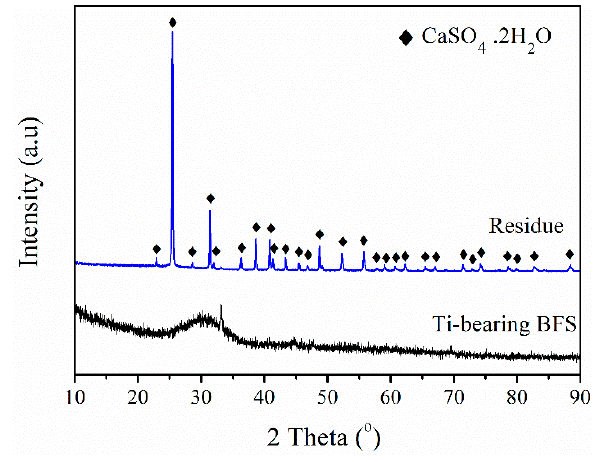
Figure 9. XRD patterns of treated blast furnace slag (BFS) and leaching residue.